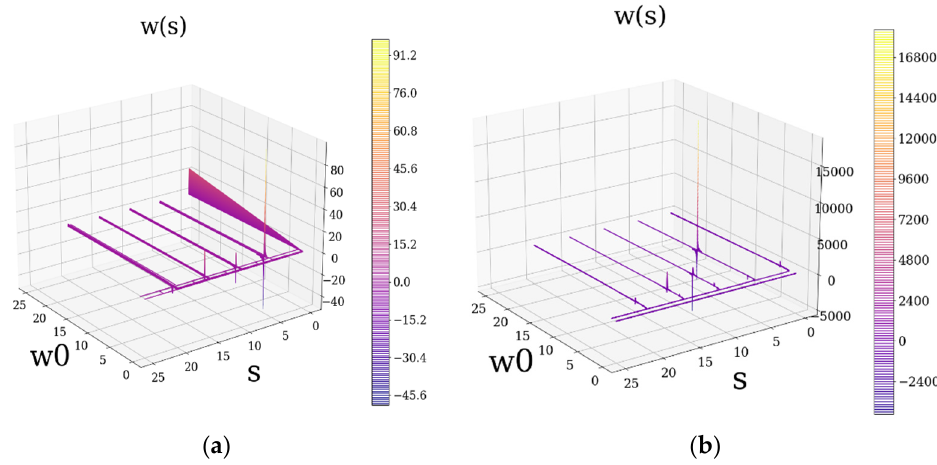
Figure 6. Plot of 𝑤(cid:4666)𝑠(cid:4667) peak in the vicinity of 𝑠 (cid:2868) . Figure 6. Plot of w ( s ) peak in the vicinity of s